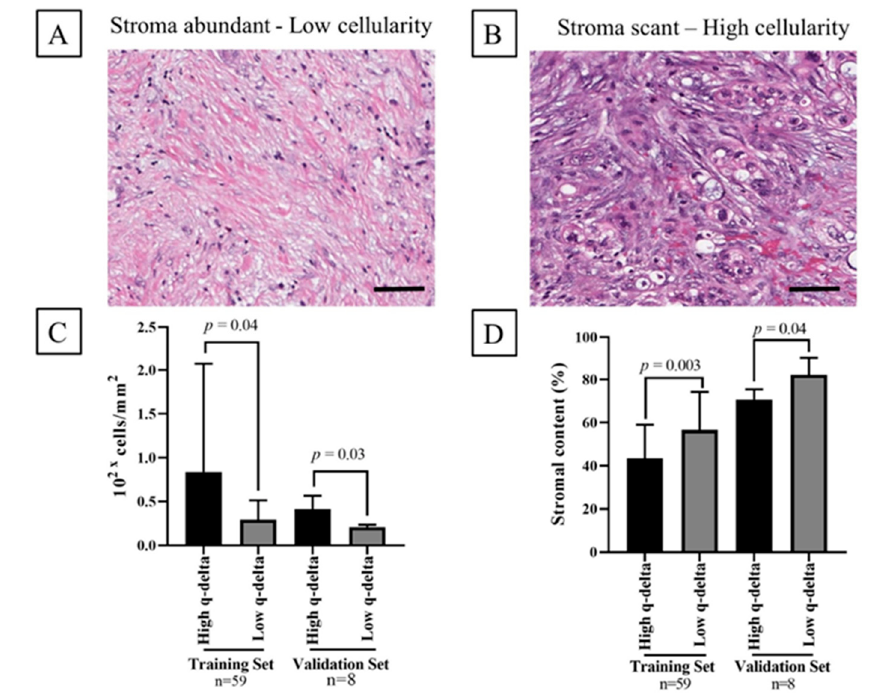
Figure 2. ( A , B ) representative H&E images of the different stromal content. Scale bar = 50 μ m .( C , D ) show the association between q-delta classification and the stromal cellularity in 59 patients from the training set (D1) and eight patients from the validation (D3) who had pathology specimens available for analysis. Cancers 2020 , 12 , x